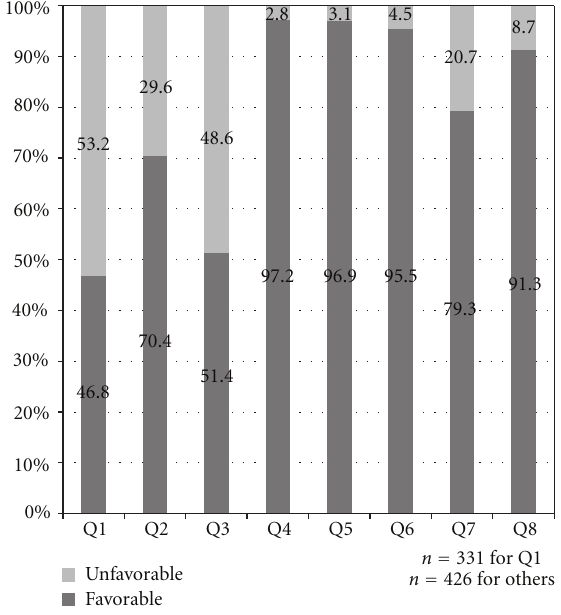
Figure 1: Patient responses for Q1 to